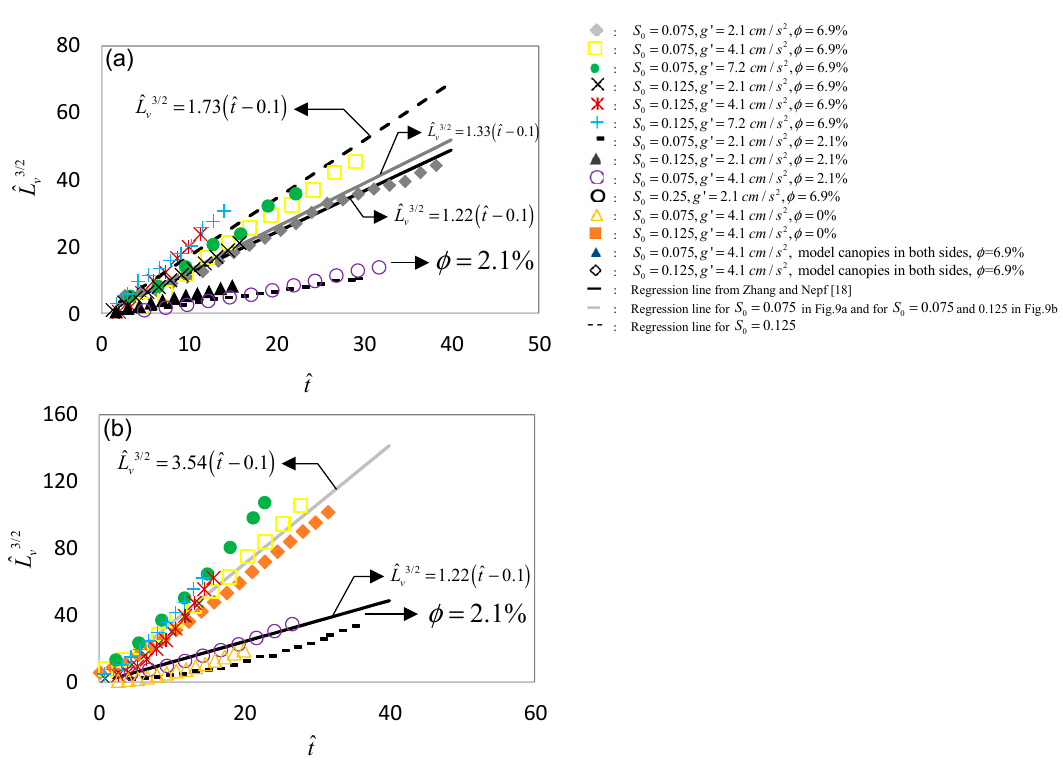
Figure 11. Normalized temporal variation in the intrusion length of the currents: ( a ) vegetation distributed in shallows; and ( b ) vegetation distributed in deep regions.